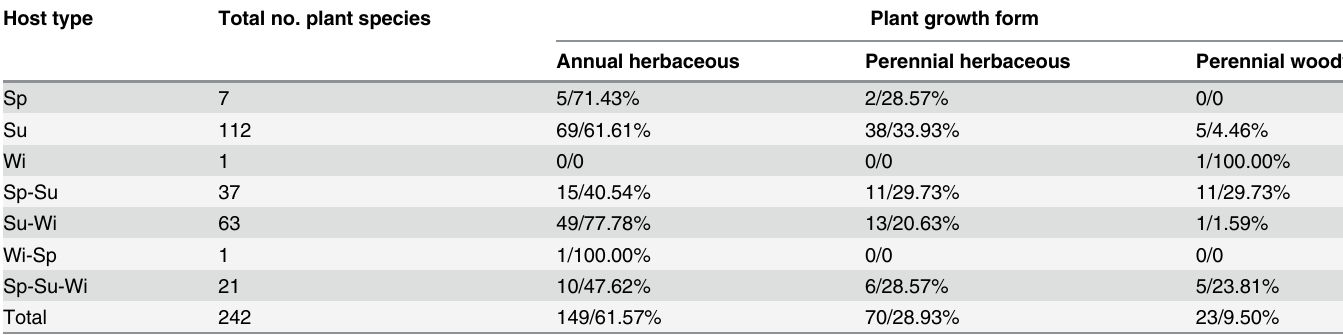
Table 4. Growth forms of plant species used as host plants by Apolygus lucorum during single and subsequent seasons.